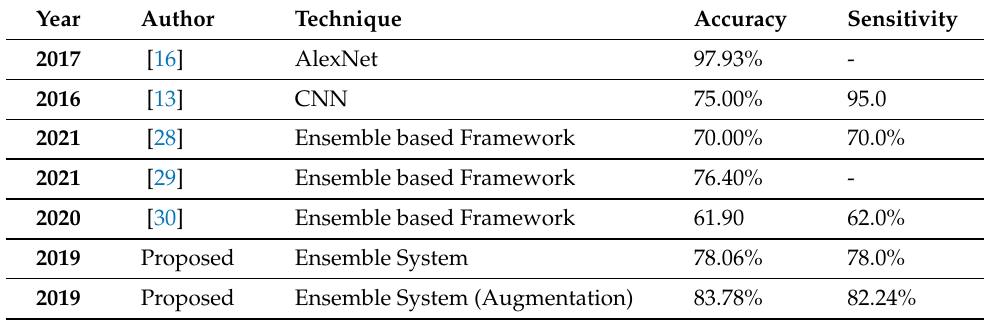
Table 13. Comparison of the proposed technique with existing